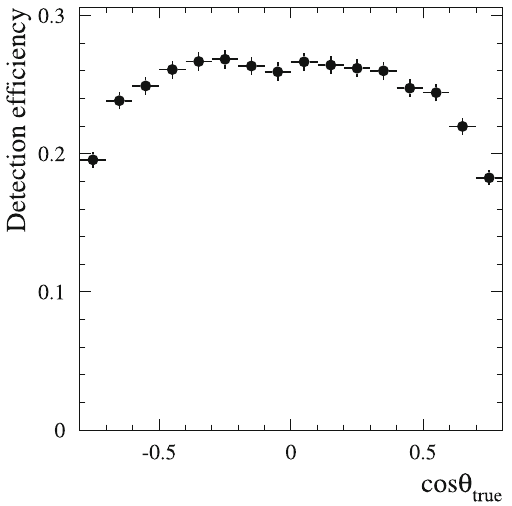
Fig. 7 The detection efficiency determined using MC simulation as a function of cos θ true , where θ true is the generated antineutron polar